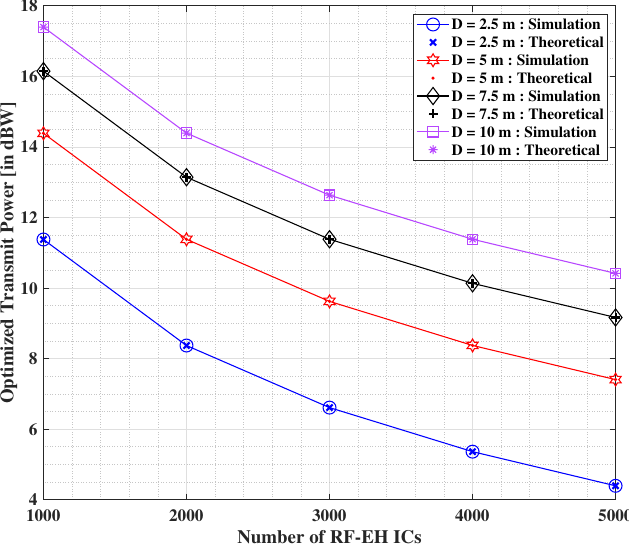
Figure 8. Minimized transmit power (in dBW) versus N for different value selections pertaining to the separation distance between the transmitter and IoT user [40].